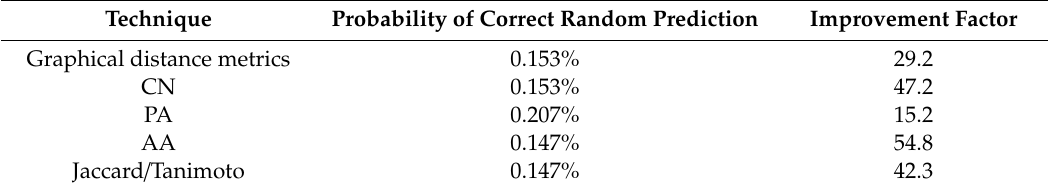
Table 5. Improvement factor of various techniques over correct random prediction [24].